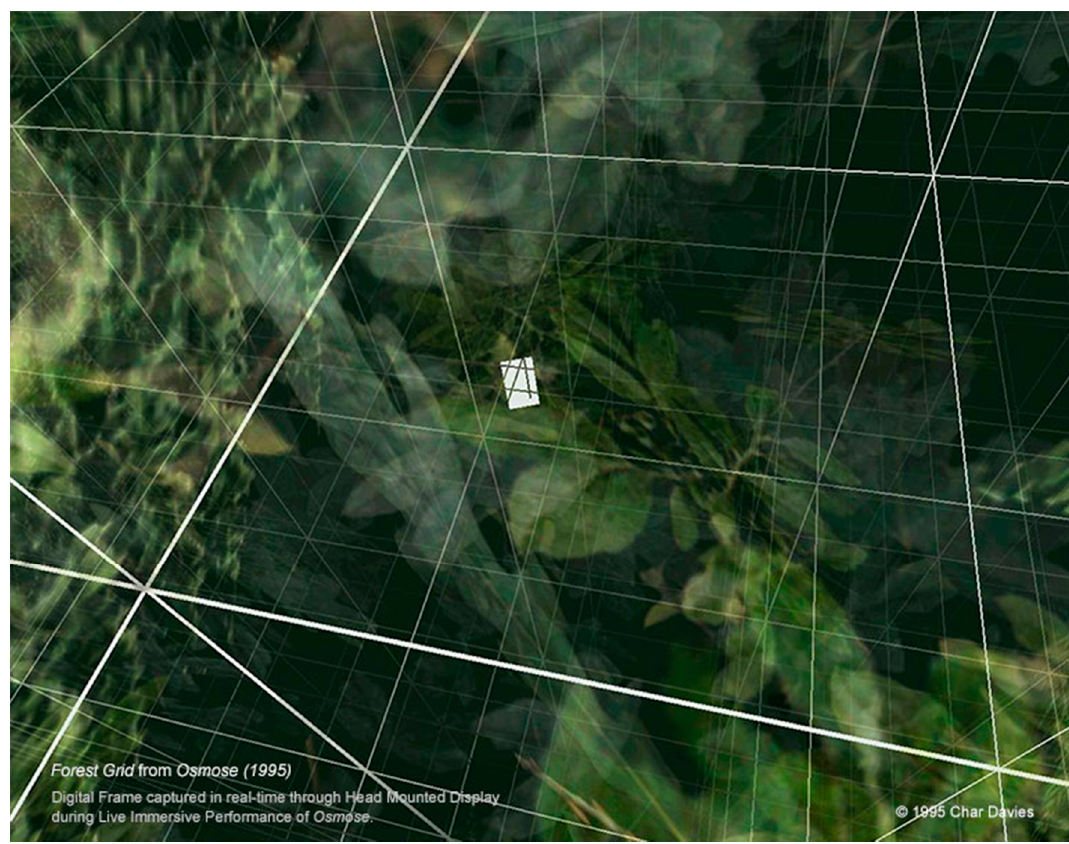
Figure 4. Digital frame from Char Davies, Osmose